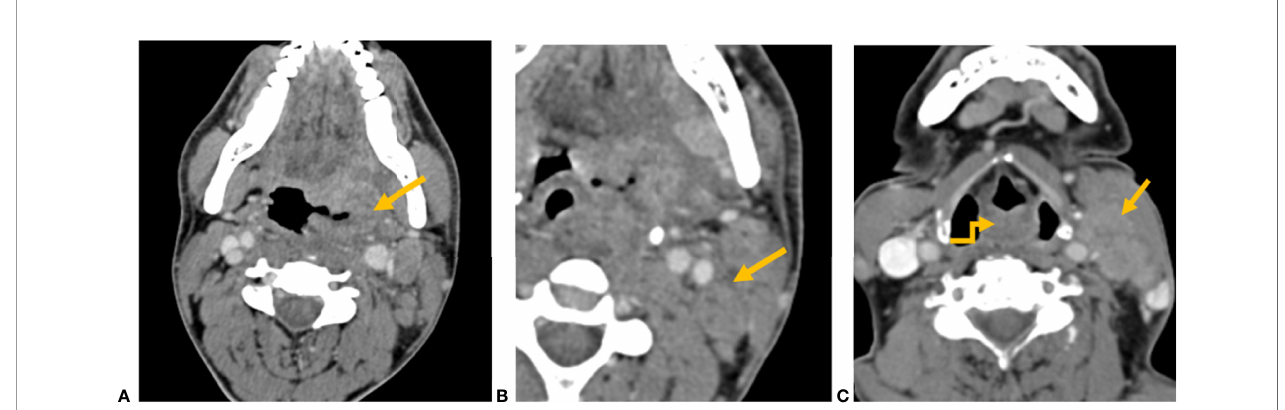
A B C FIGURE 4 | CT axial image shows (A) left tonsillar fossa SCC (yellow arrow) and (B) metastatic left level II node showing capsular irregularity and surrounding fat stranding (yellow arrow), representing extranodal extension. (C) CT axial image shows an ill-de fi ned mass involving the aryepiglottic fold (yellow elbow arrow). Metastatic left level II node with gross muscle invasion represents extranodal extension (yellow arrow).